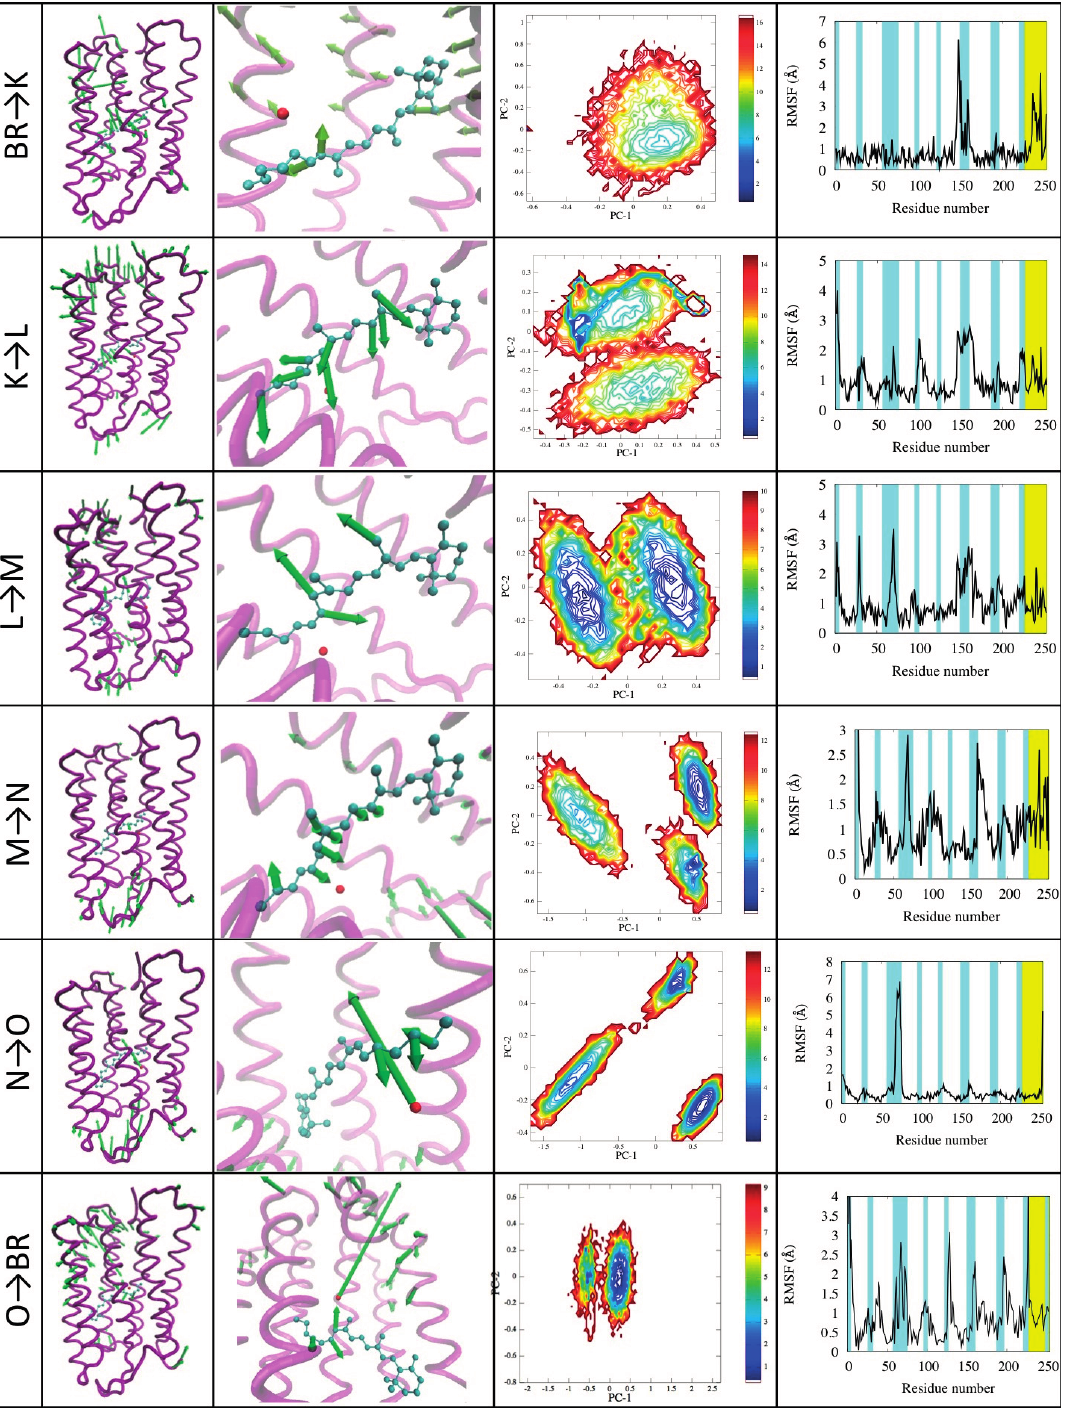
Figure 7. Illustration of the photocycle transitions. For each transition (indicated in the first column) the motion projected onto the first principal component is represented in the 3D structure with green arrows whose length is proportional to the displacement of the corresponding beads/atoms (second column; arrows shorter than a cutoff are not represented for clarity). A zoom on the active site shows in detail the motion of the retinal (third colum). The plots show the contour plots of the free energy landscape as a function of the first two principal components (fourth column) and the RSMF evaluated using the first principal component (fifth